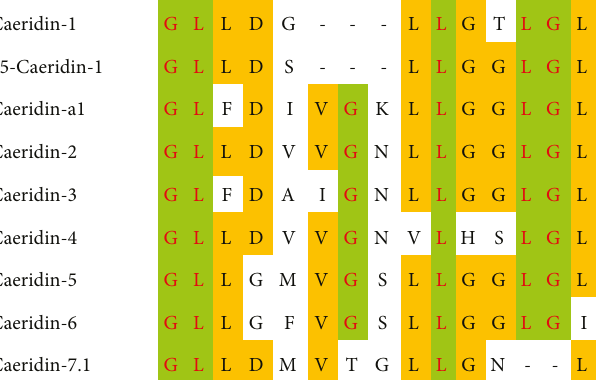
Figure 3: Alignments of amino acid sequences of Caeridins identi fi ed from L. caerulea . The identical and conservative amino acids were highlighted in green and orange,